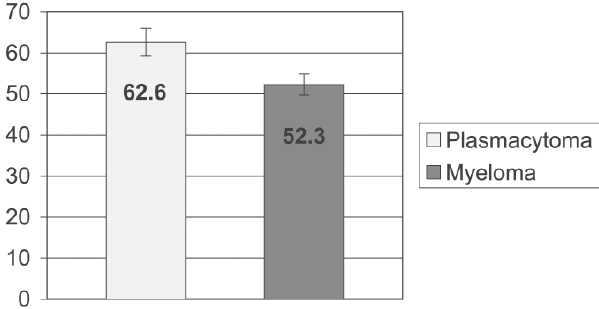
Figure 1 - Age (years) of patients with plasmacytoma at the time of the first visit and of patients with plasmacytoma that progressed to multiple